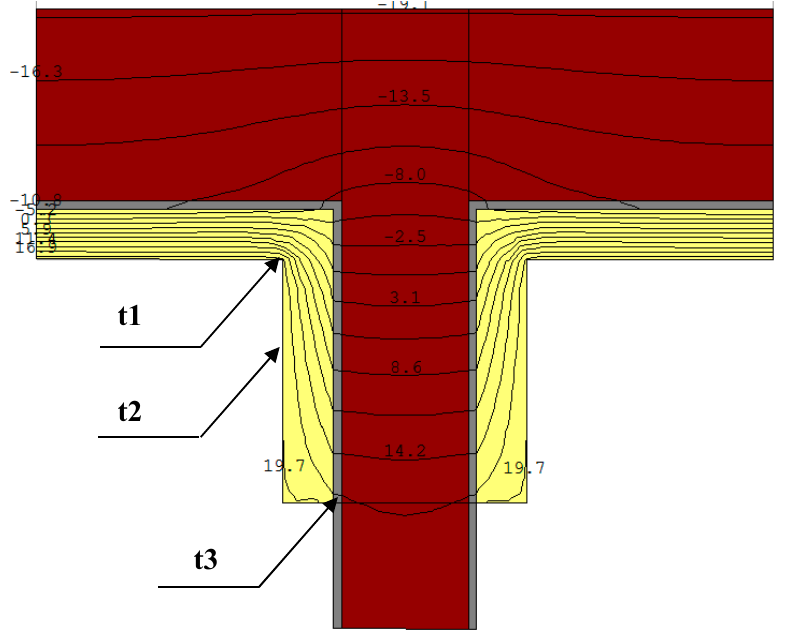
Figure 11. Distribution of isotherms for variant B.